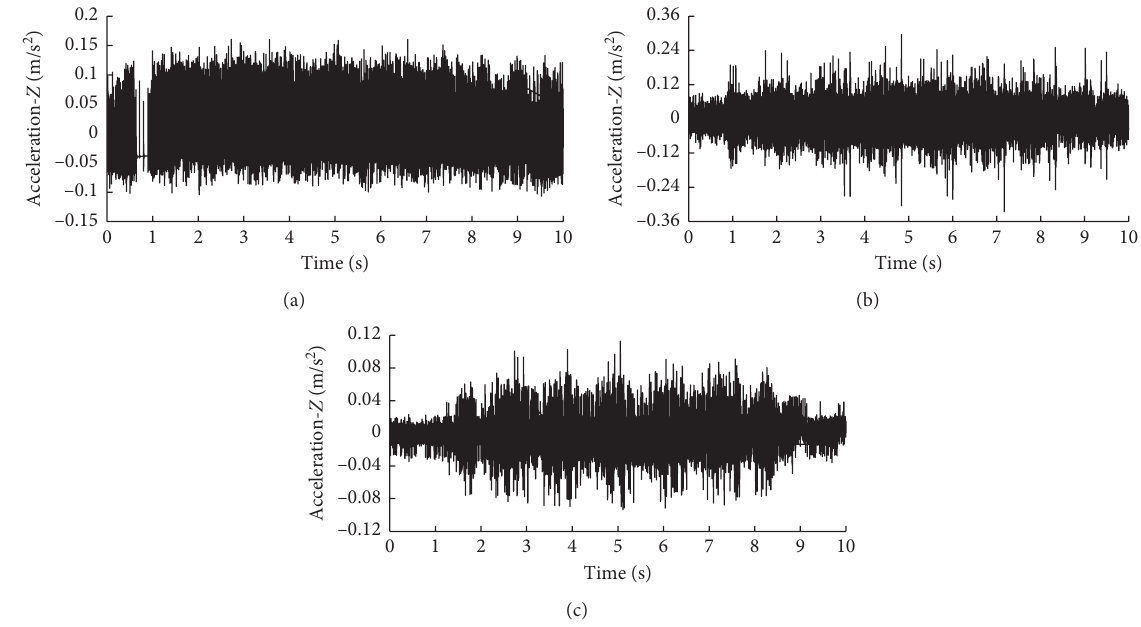
Figure 12: Time history curves of vertical accelerations: (a) A021; (b) A024; (c) A027.